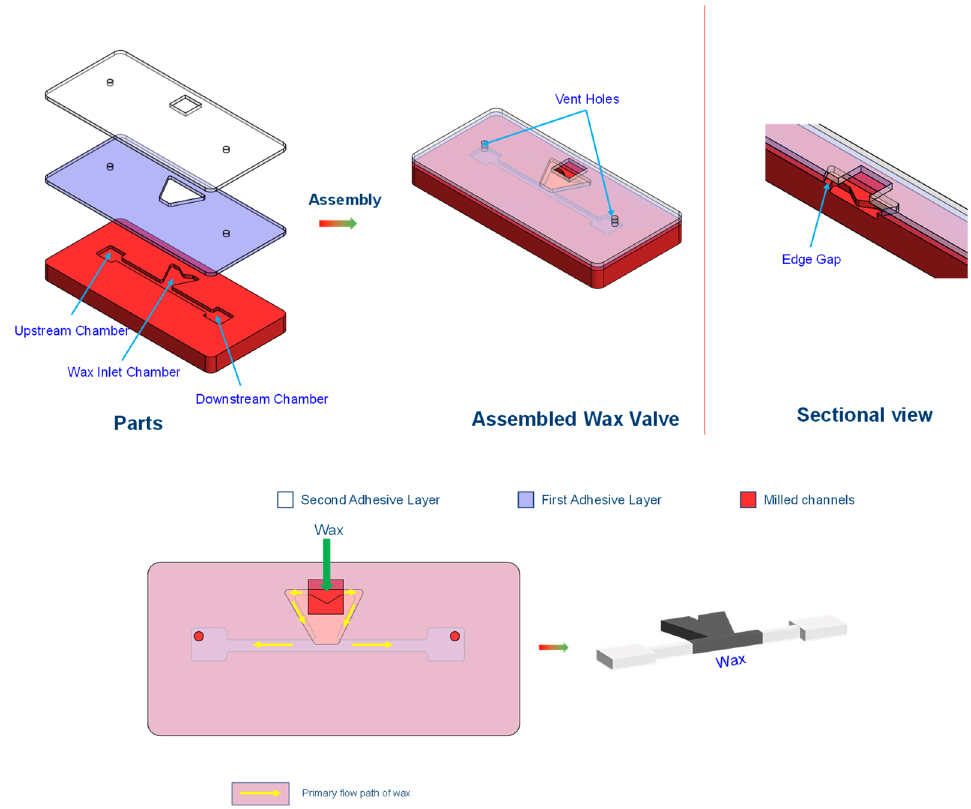
Figure 17. Assembly of the capillary ‐ driven wax valve. The sectional view: location of the edge gaps and the main reservoir channel where the molten wax flows due to capillary action. Bottom figure: operation of the wax valve and how the wax flows into the valving channel. Vent holes are required in both upstream and downstream chambers. The figure was reconstructed from sources cited [44].